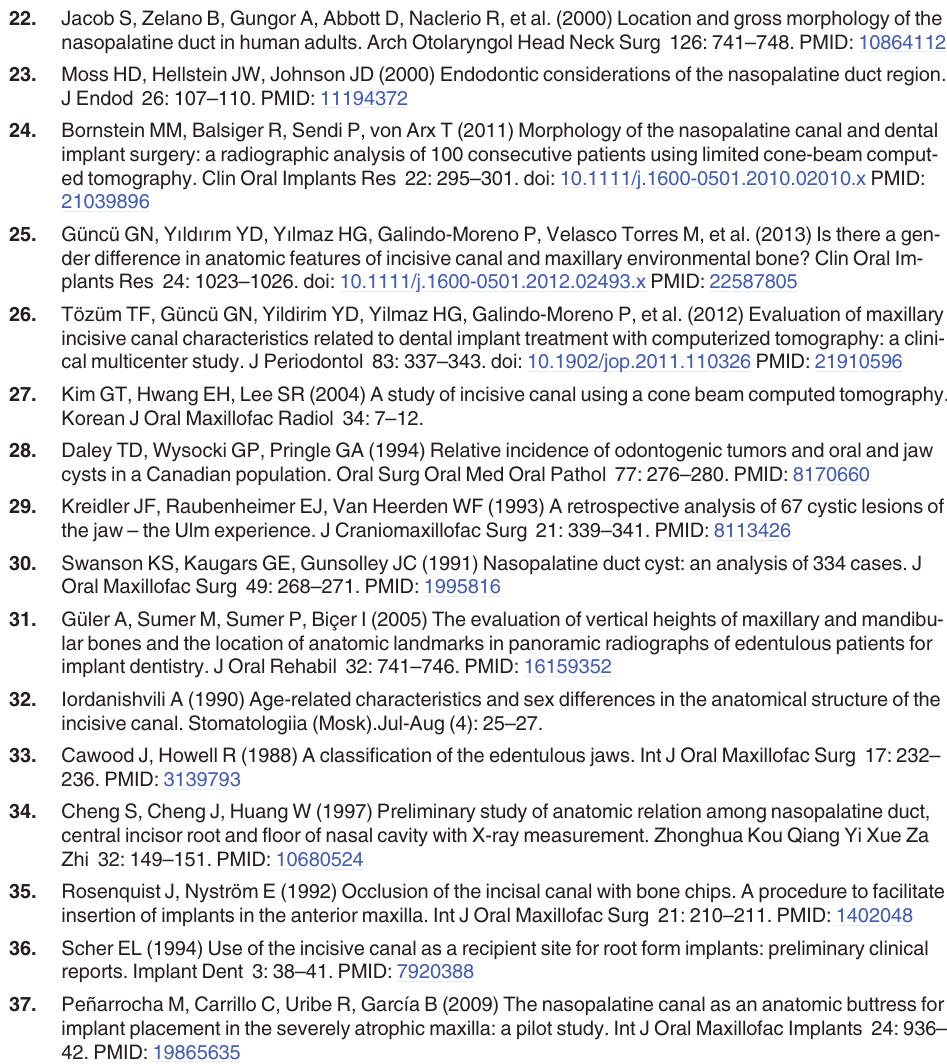
PLOS ONE | DOI:10.1371/journal.pone.0117251 February 13,